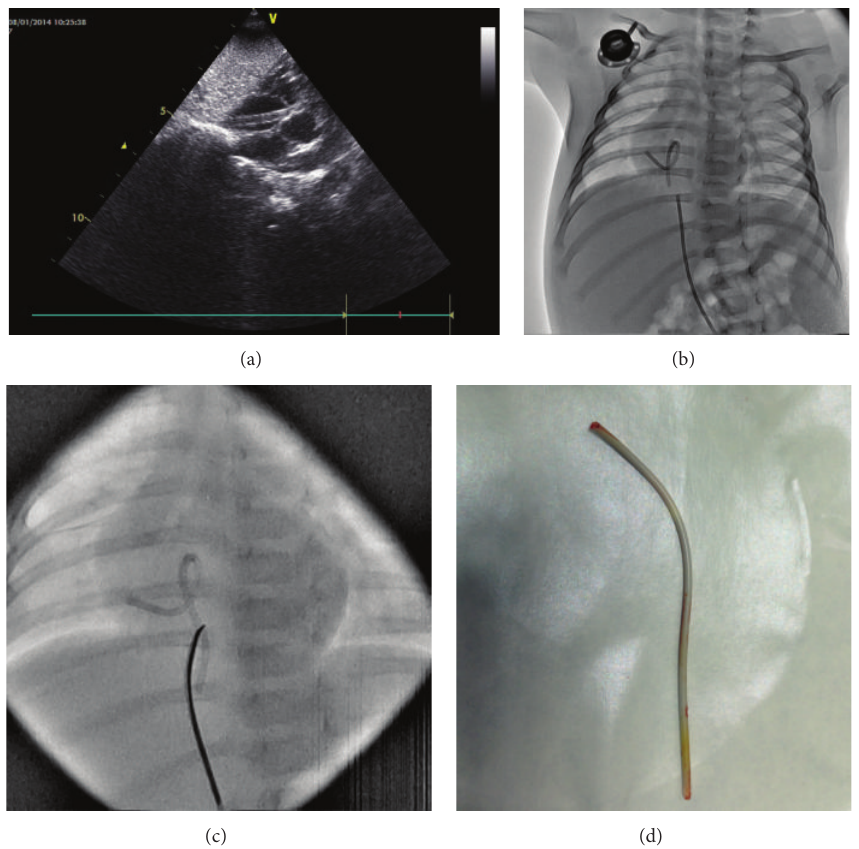
Figure 1: (a) Echocardiographic and (b) angiographic images of an embolized catheter making a loop in the heart of a 4.5-month-old infant and (c) images of its retrieval via snare are shown. (d) The embolized port